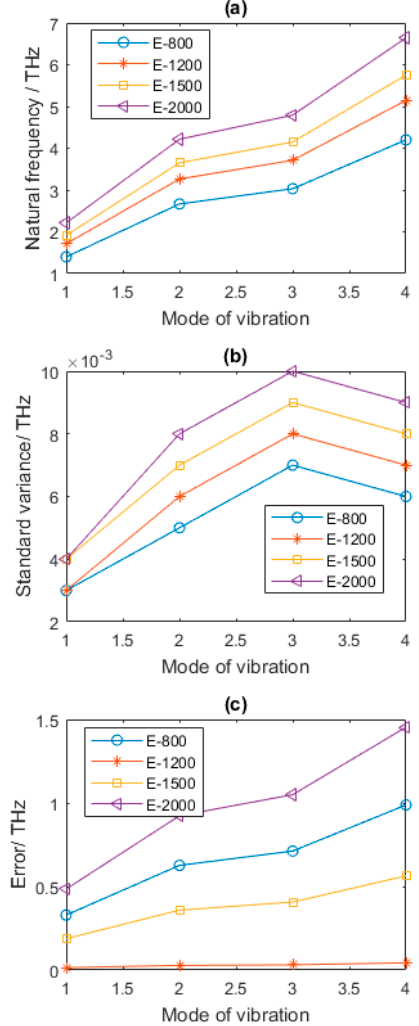
Figure 9. Statistical results of defected graphene sheets with different Young’s modulus ( a – c for mean, standard variance and Error of natural frequency, respectively). E is Young’s modulus of graphene sheets.